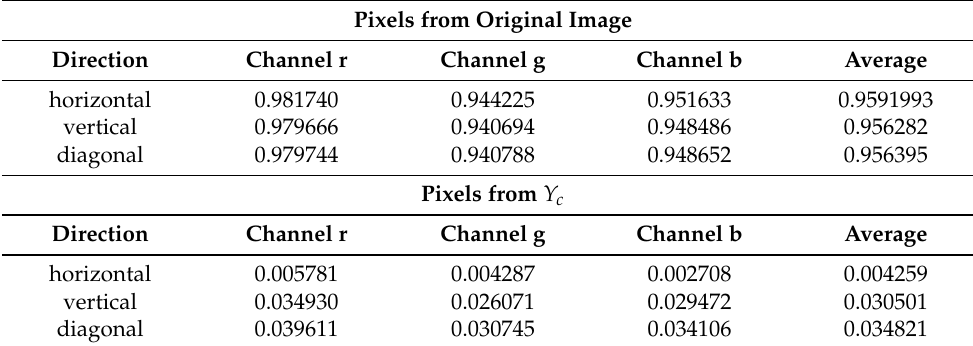
Table 7. Correlation values of adjacent pixels in image